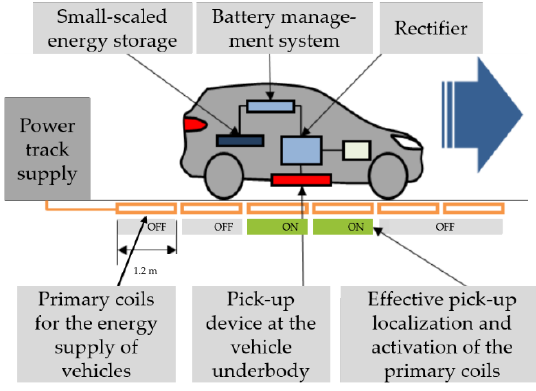
Figure 3. System for WPT in moving cars [20].